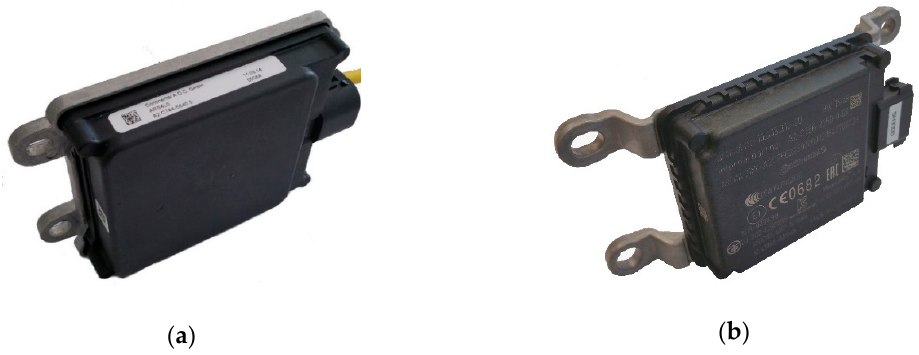
Figure 1. Radar sensors ARS-40X showing. On the right side of the sensors, are the CAN interface connector. ( a ) ARS-408 and ( b ) ARS-404.